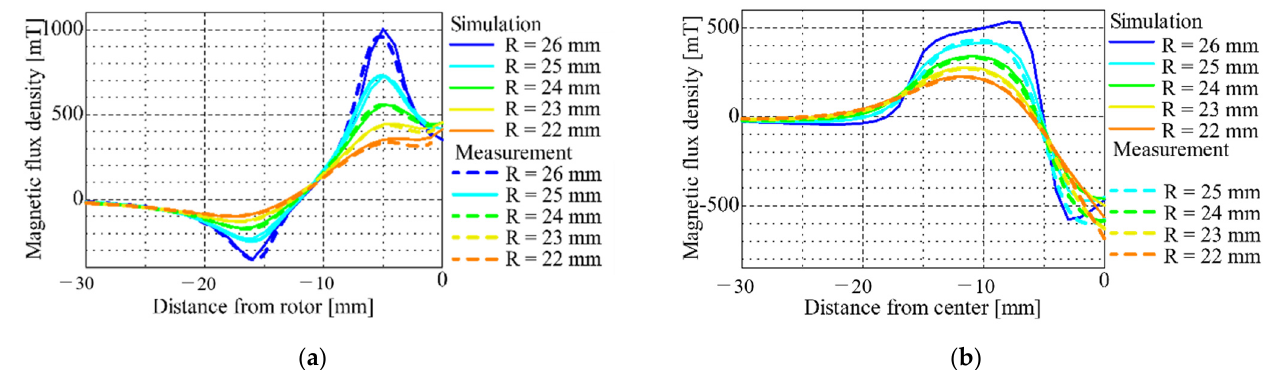
Figure 7. Comparison of magnetic flux density at the side of the HTS: ( a ) Radial simulation and measurement results, ( b ) Axial simulation and measurement results.